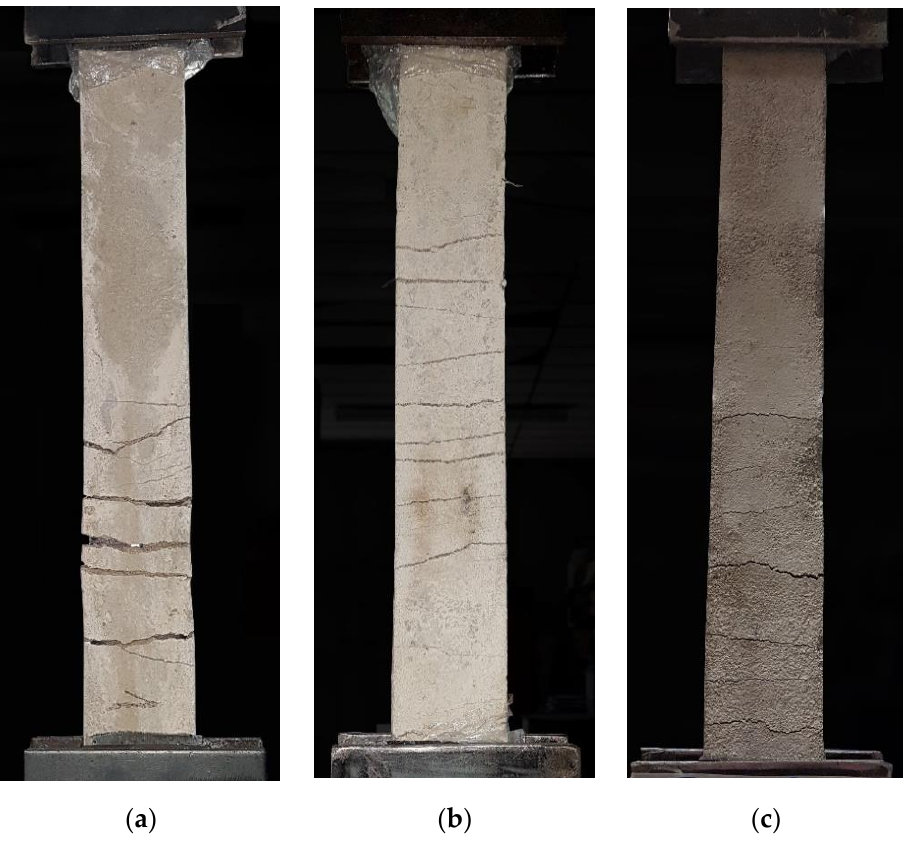
Figure 9. Fissure formation in test bodies with ( a ) untreated reinforcement, ( b ) SBR impregnated reinforcement, and ( c ) SBR + SF impregnated reinforcement. Table 2. Average width and fissured area for direct tensile testing of the composite.